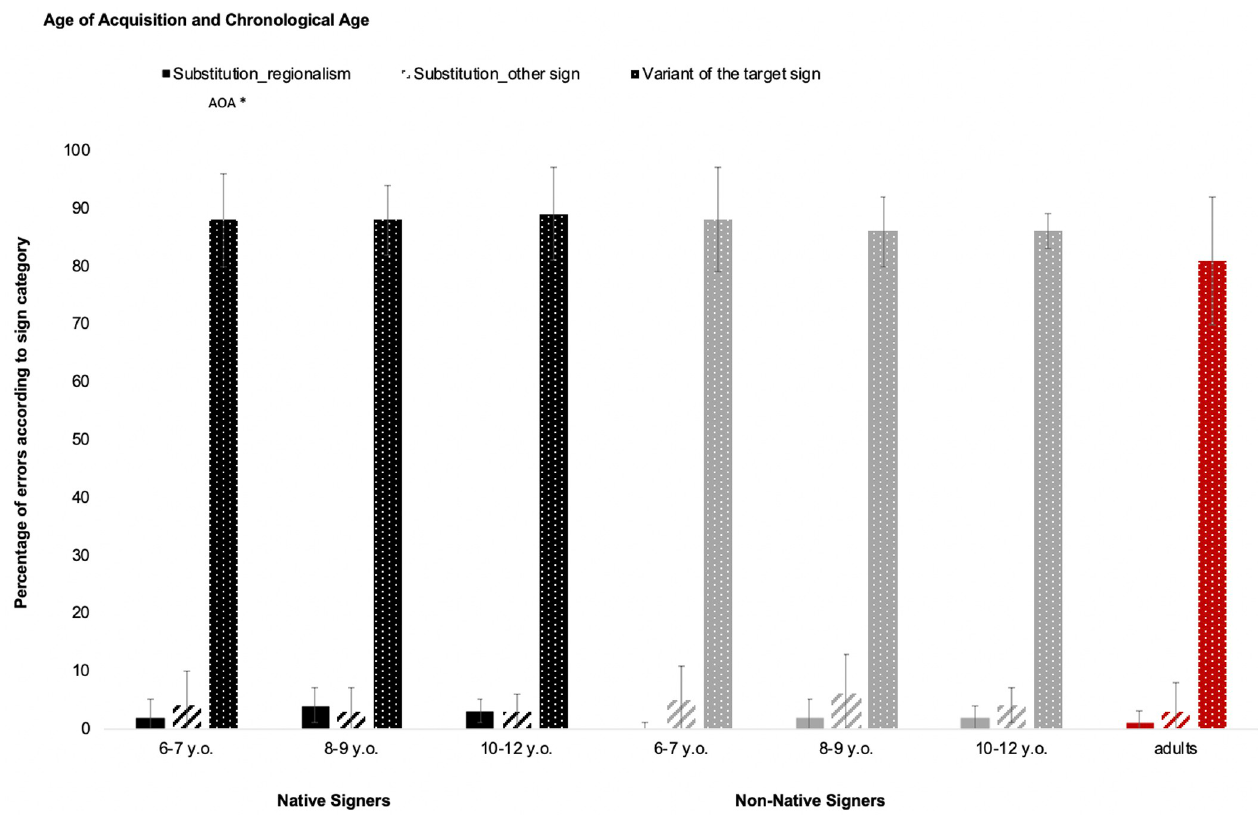
Fig 3. Percentage of errors according to sign category (substitution_other sign, substitution_regionalism or variant of the target sign) with respect to age of acquisition and chronological age. Adults are considered as the control group ( ��� p < .001; �� p < .01; � p < .05; n.s. p > .05).